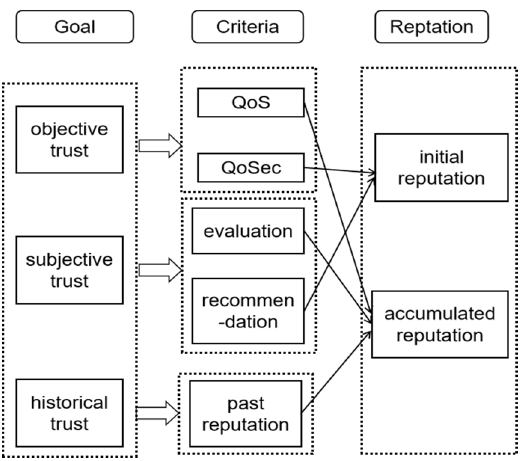
Figure 3. Hierarchy of reputation evaluation model.